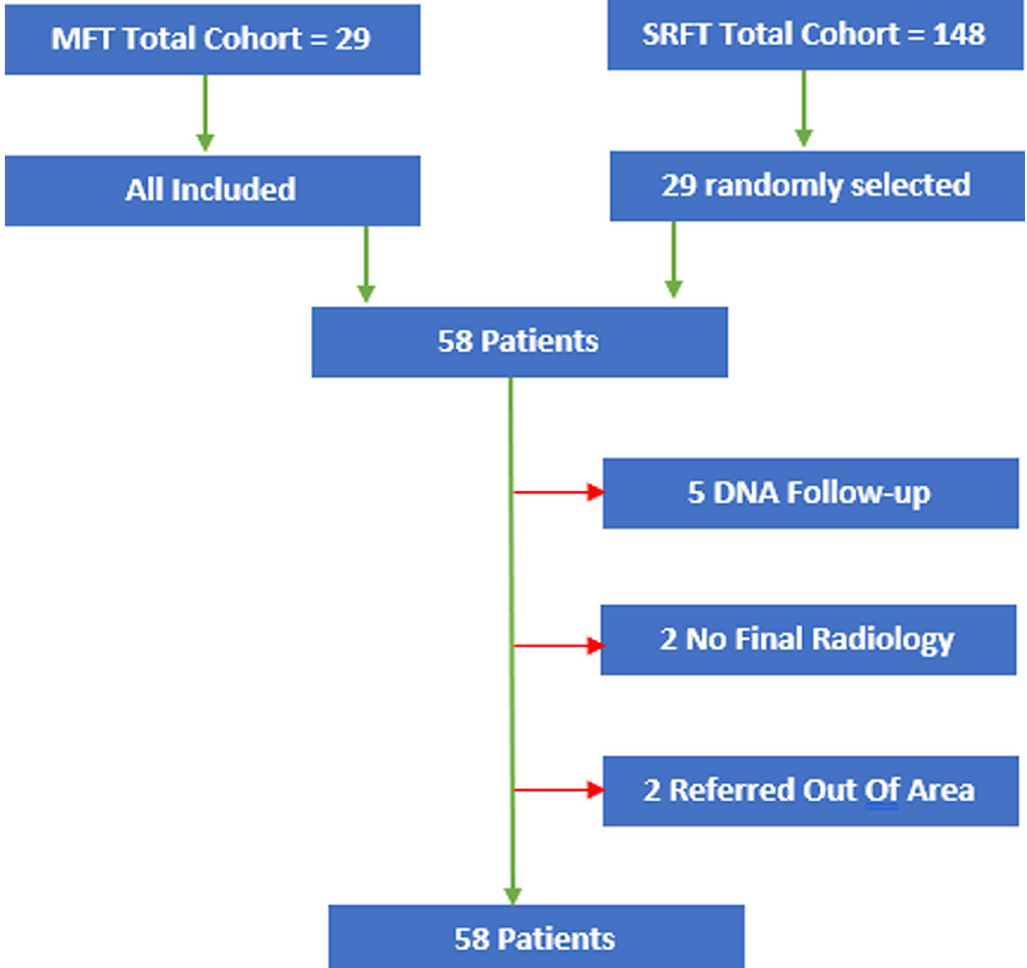
Figure 1. Patient sample fl ow chart, showing initial recruitment, exclusions with reasons speci fi ed, and fi nal included patient sample.